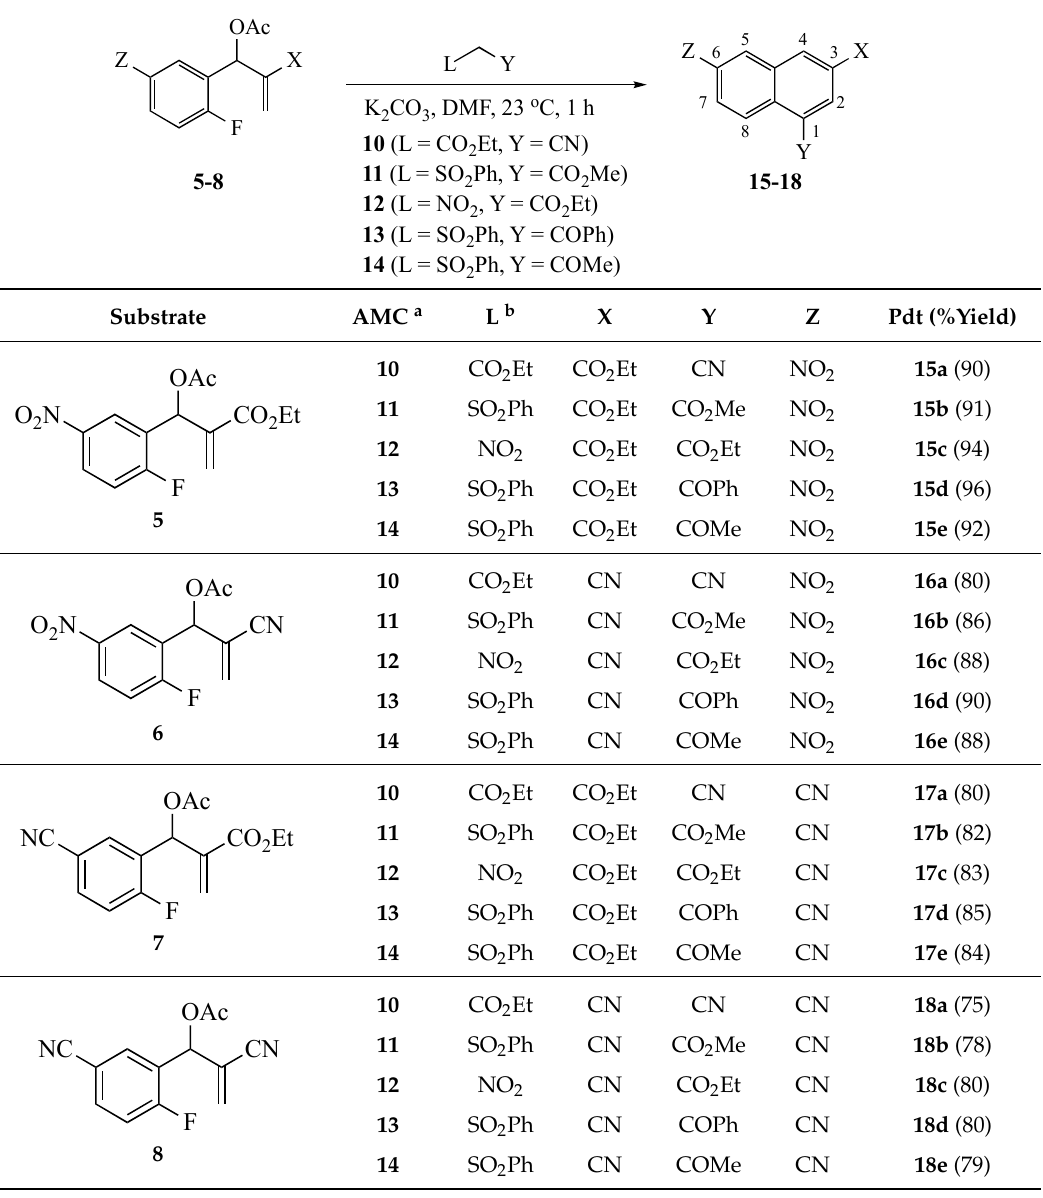
Table 1. Formation of naphthalenes.